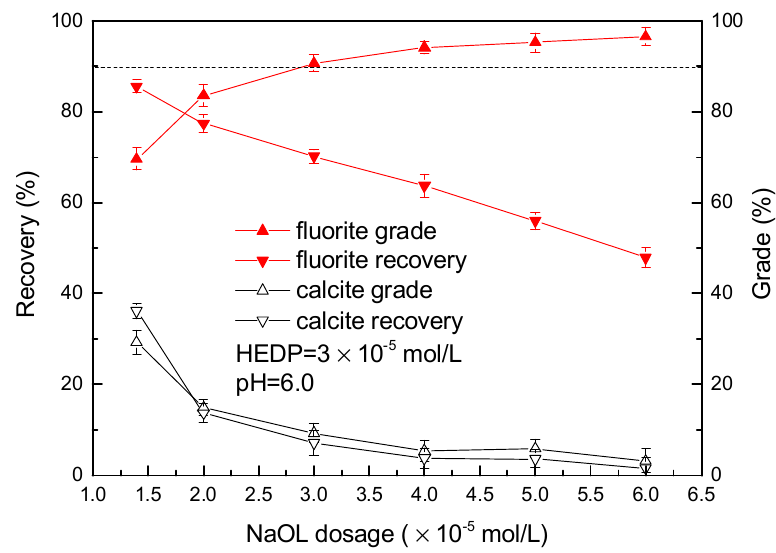
Figure 2. Effect of sodium oleate (NaOL) dosage on the separation performance of binary mixed minerals using the novel reagent scheme.